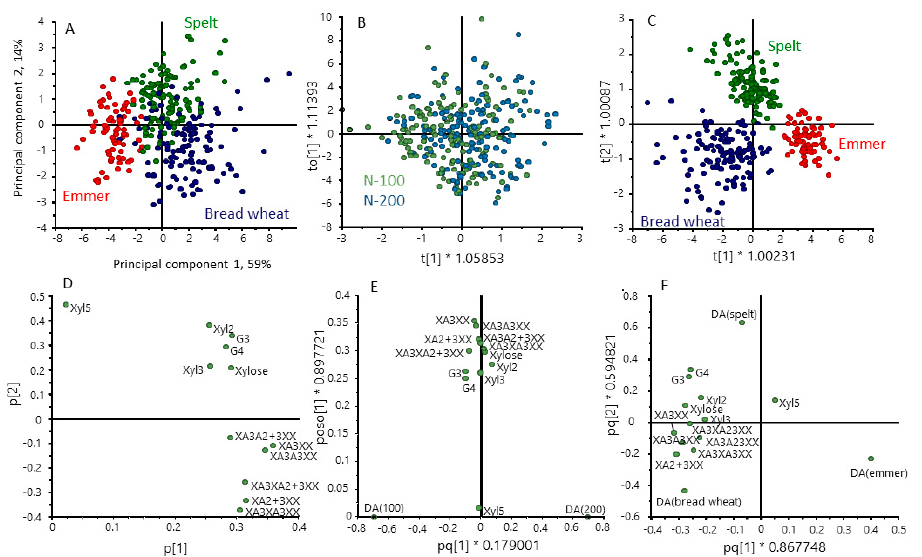
Figure 6. Multivariate analysis of the contents of AXOS and GOS in grains of the three cereal types grown in four environments. Principal component analysis PCA ( A ) and orthogonal partial least squares discrimination analysis (OPLS-DA) ( B , C ) selecting for differences between nitrogen treatments ( B ) and cereal types ( C ). ( D – F ) loading plots for ( A – C ), respectively. Colour code: red, emmer; green, spelt; blue, bread